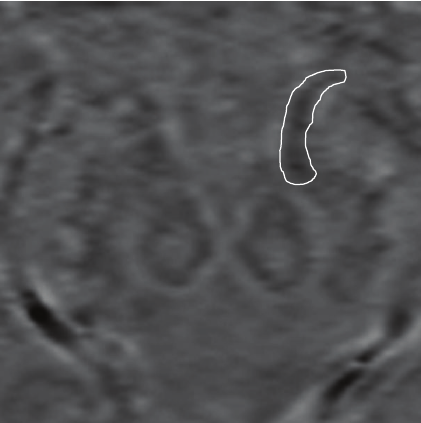
Figure 4: ROI around the FN as seen on mIPs of susceptibility maps (SWIM, 8